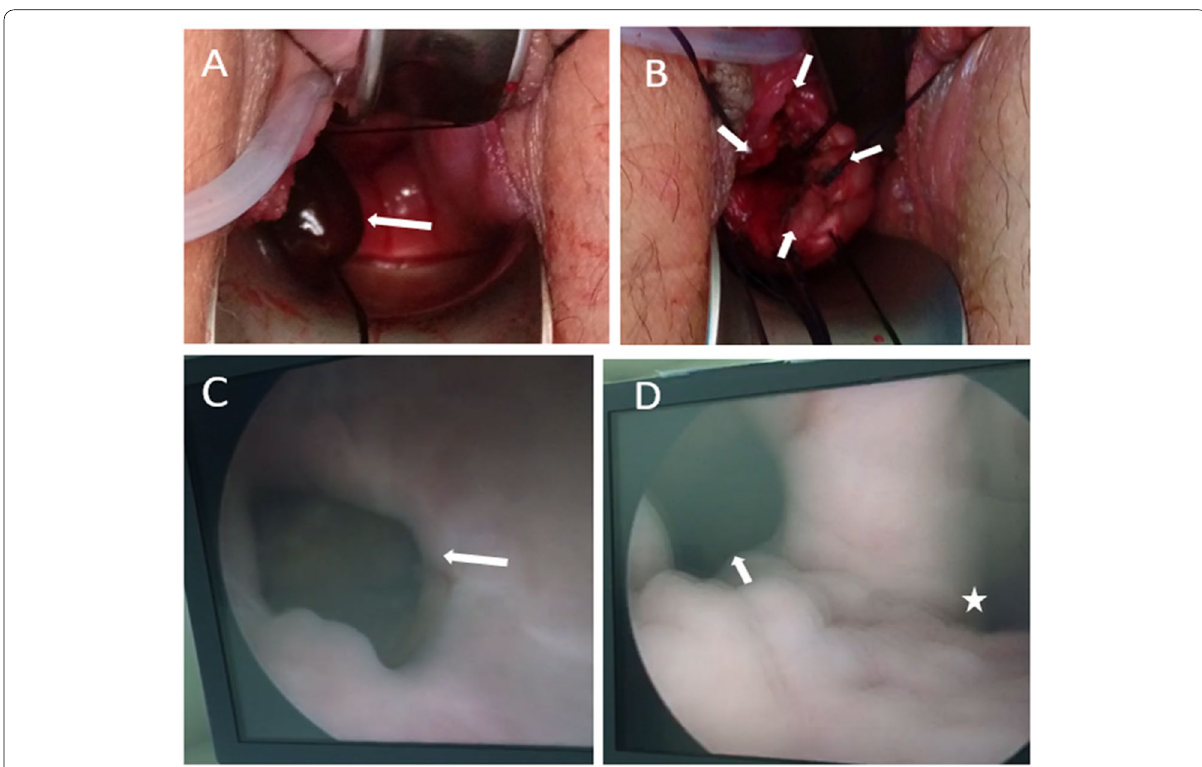
Fig. 3 Intraoperative views showed A intraoperative resection of vaginal septum with the chocolate materials coming-out from obstructed right hemi-vagina (arrow), B sutured edges of the opened right hemi-vagina (4 arrows), C colposcopic view showing the healed edges of the opened right hemi-vagina 3 months post-operative, and D colposcopic view of right hemi-vagina (arrow) and left hemi-vagina (star)